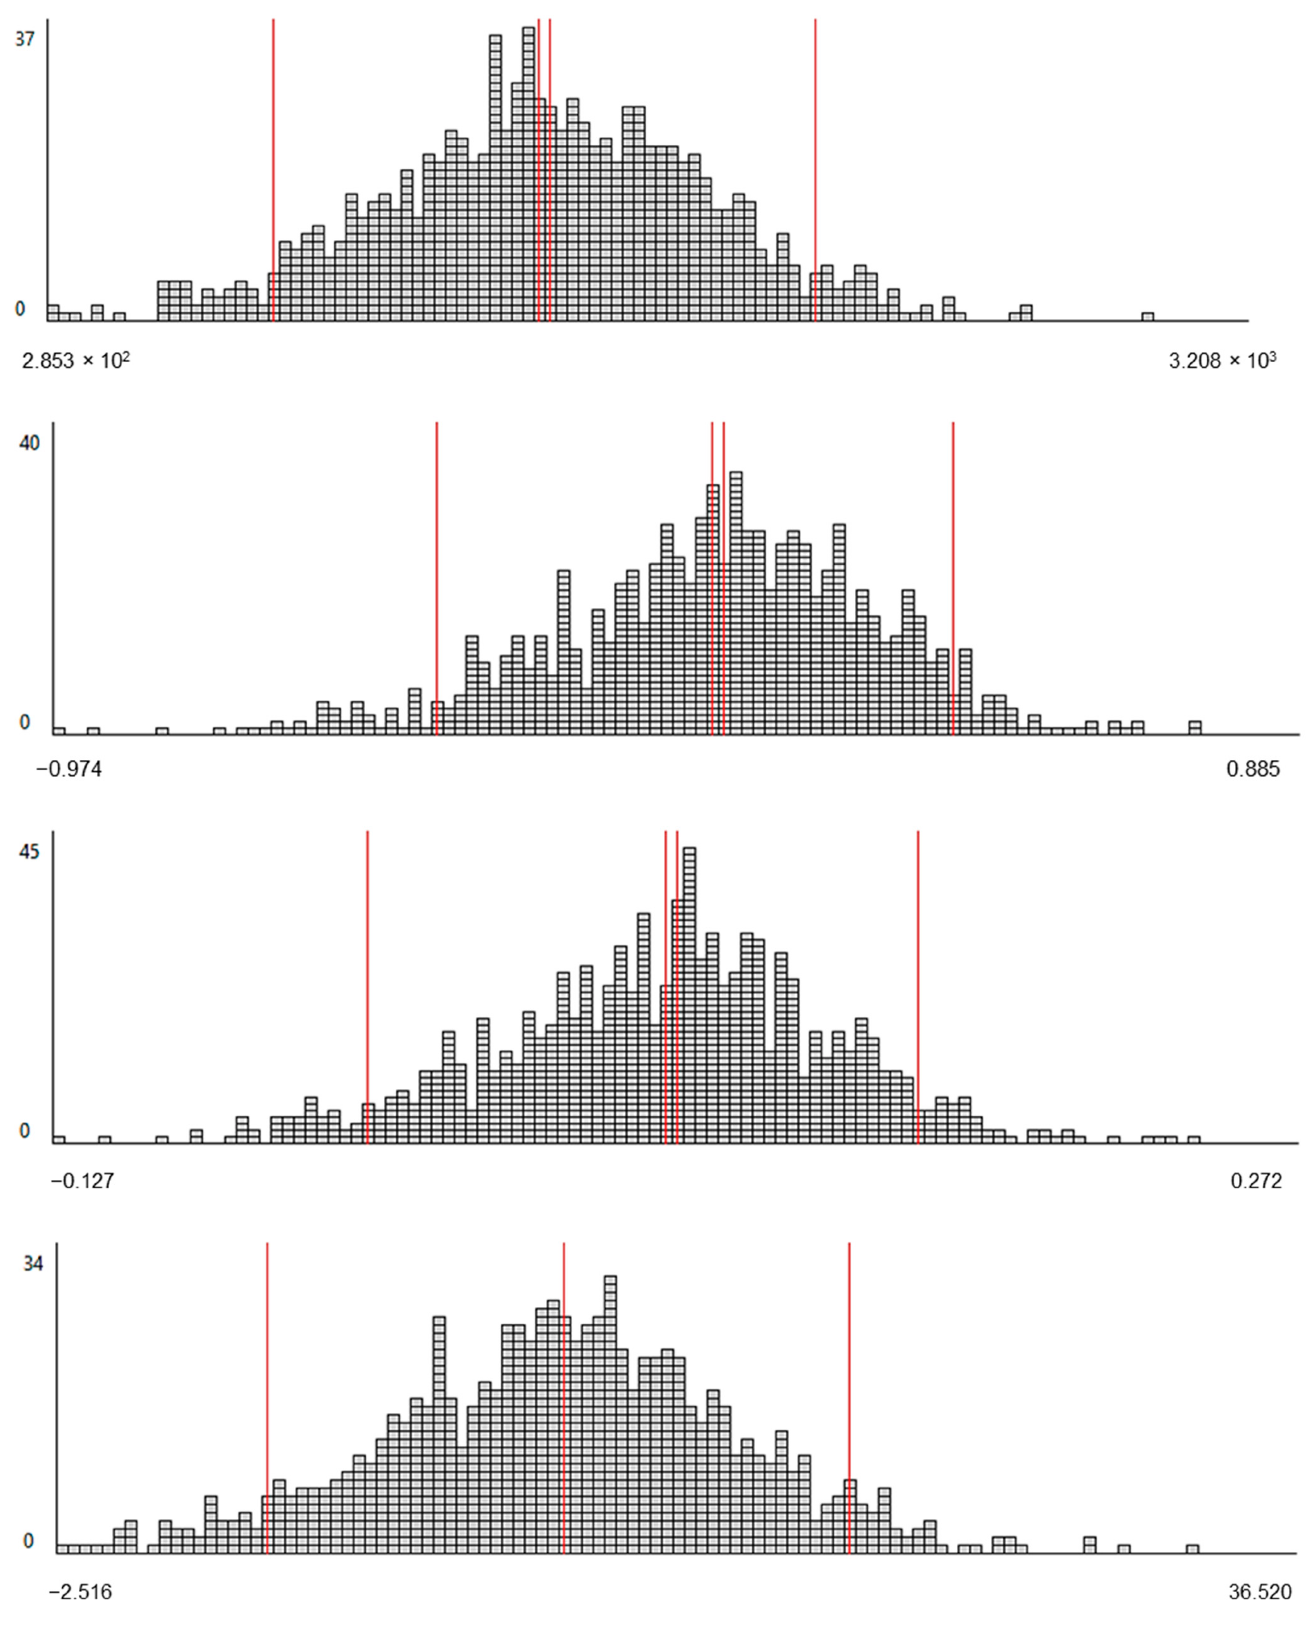
Figure 5. Statistical distribution of results for each impact category (in order: climate change, human toxicity, land use, marine eutrophication, particulate matter and water resource depletion). Red lines depict mean, median and standard deviation as visual representation of data dispersion.